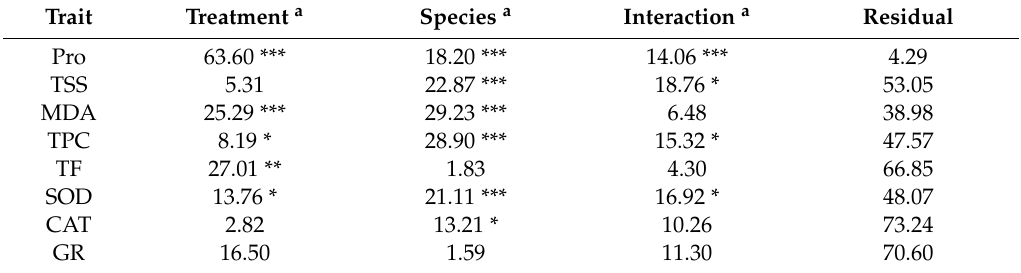
Table 4. Two-way analysis of variance (ANOVA) of treatment, species, and their interactions for the parameters considered. Numbers represent percentages of sum of squares (SS) at the 5% confidence level. Abbreviations: proline (Pro), total soluble sugars (TSSs), malondialdehyde (MDA), total